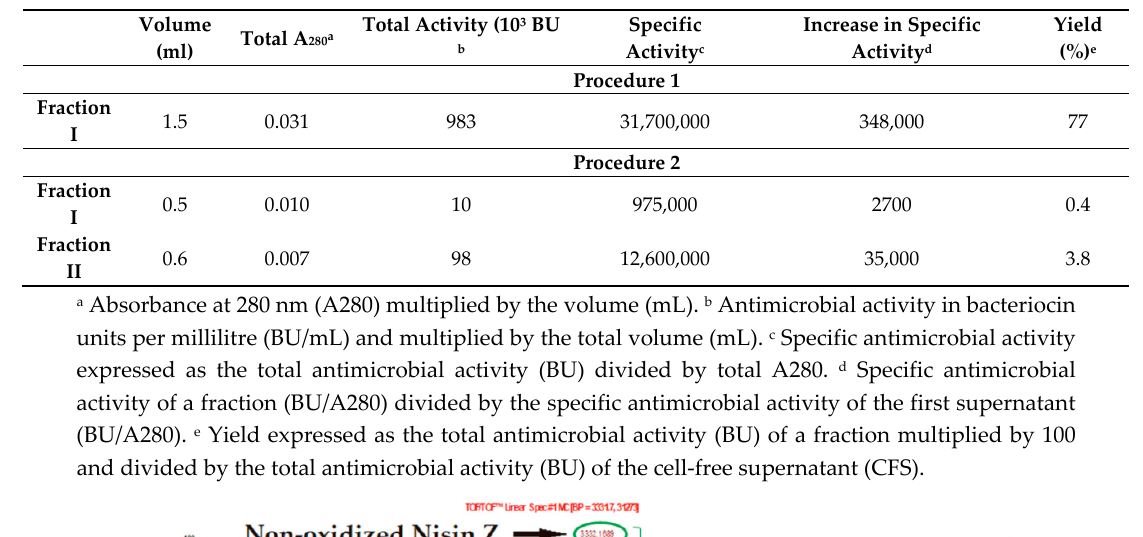
Table 1. Final RP-FPLC of bacteriocins from L. lactis RBT18 by using two multi-chromatographic purification procedures.